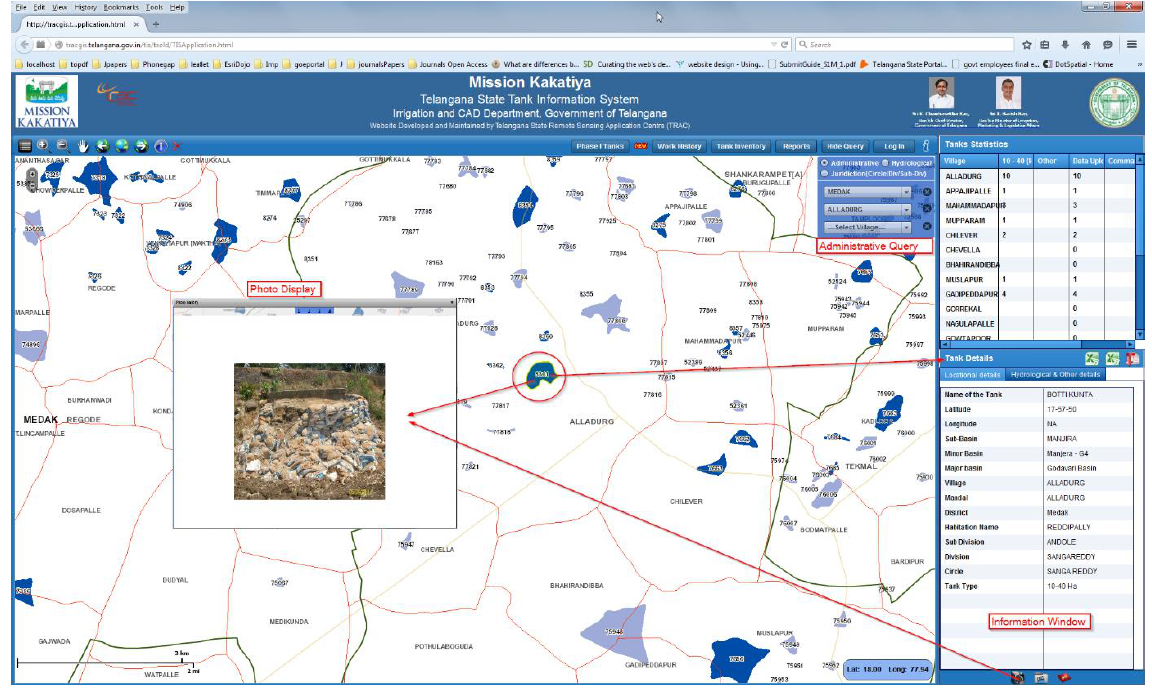
Figure 2 : TIS Application developed using ArcGIS API for